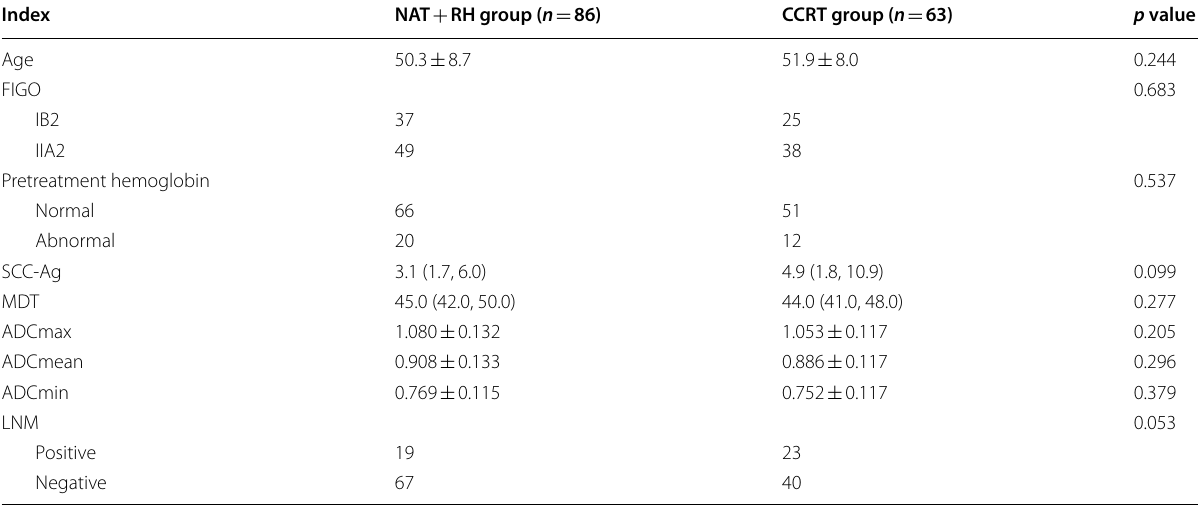
Table 3 Comparison of clinical indices, histopathologic factors and imaging indices between neoadjuvant therapy followed by radical hysterectomy group and concurrent chemoradiotherapy